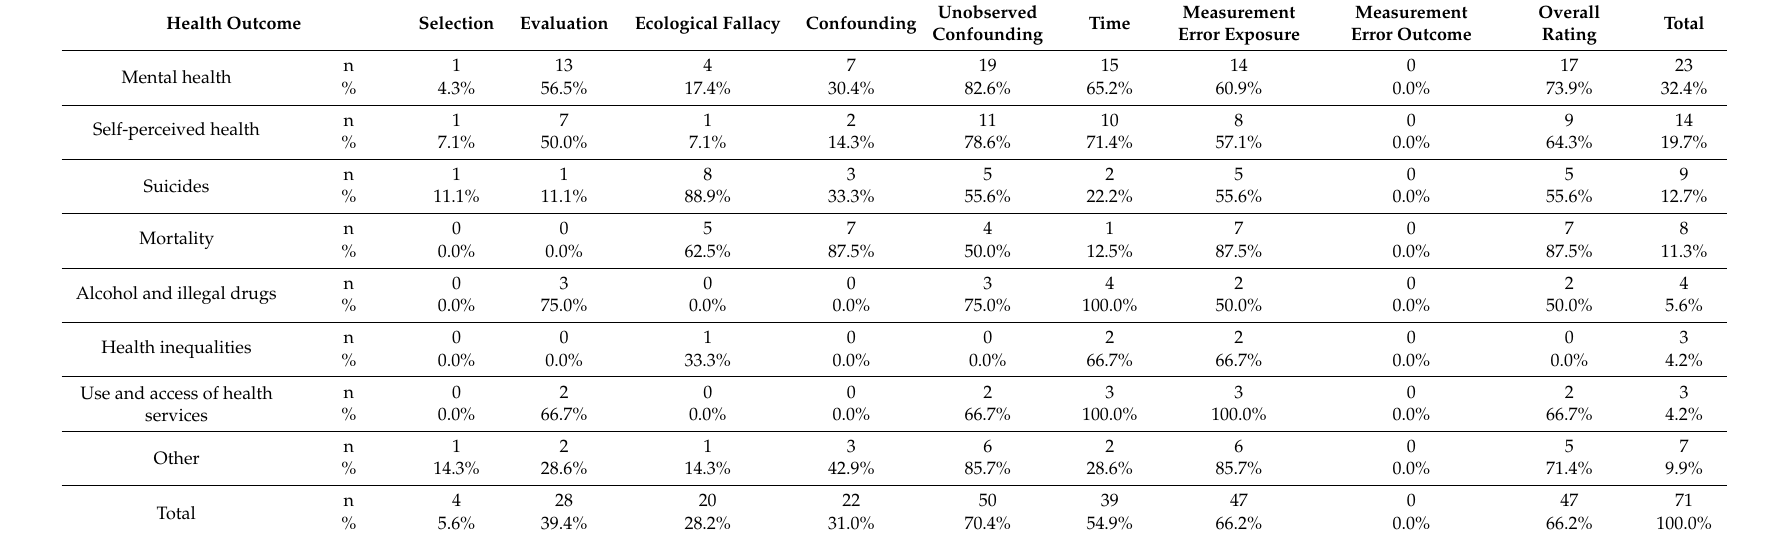
Table 3. Studies with high risk of bias (rated with 3) by health outcome and bias